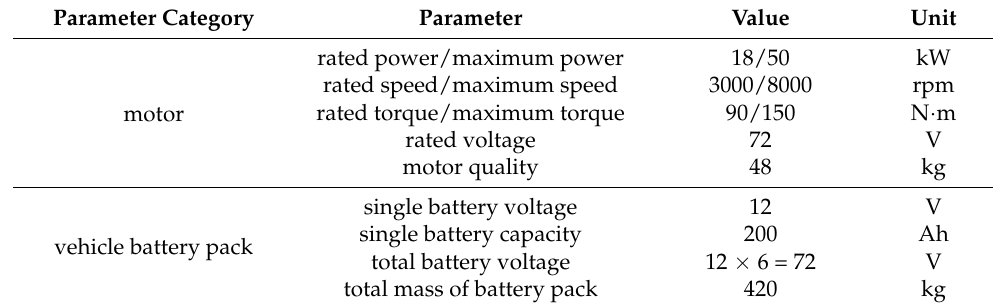
Table 4. Module parameters.